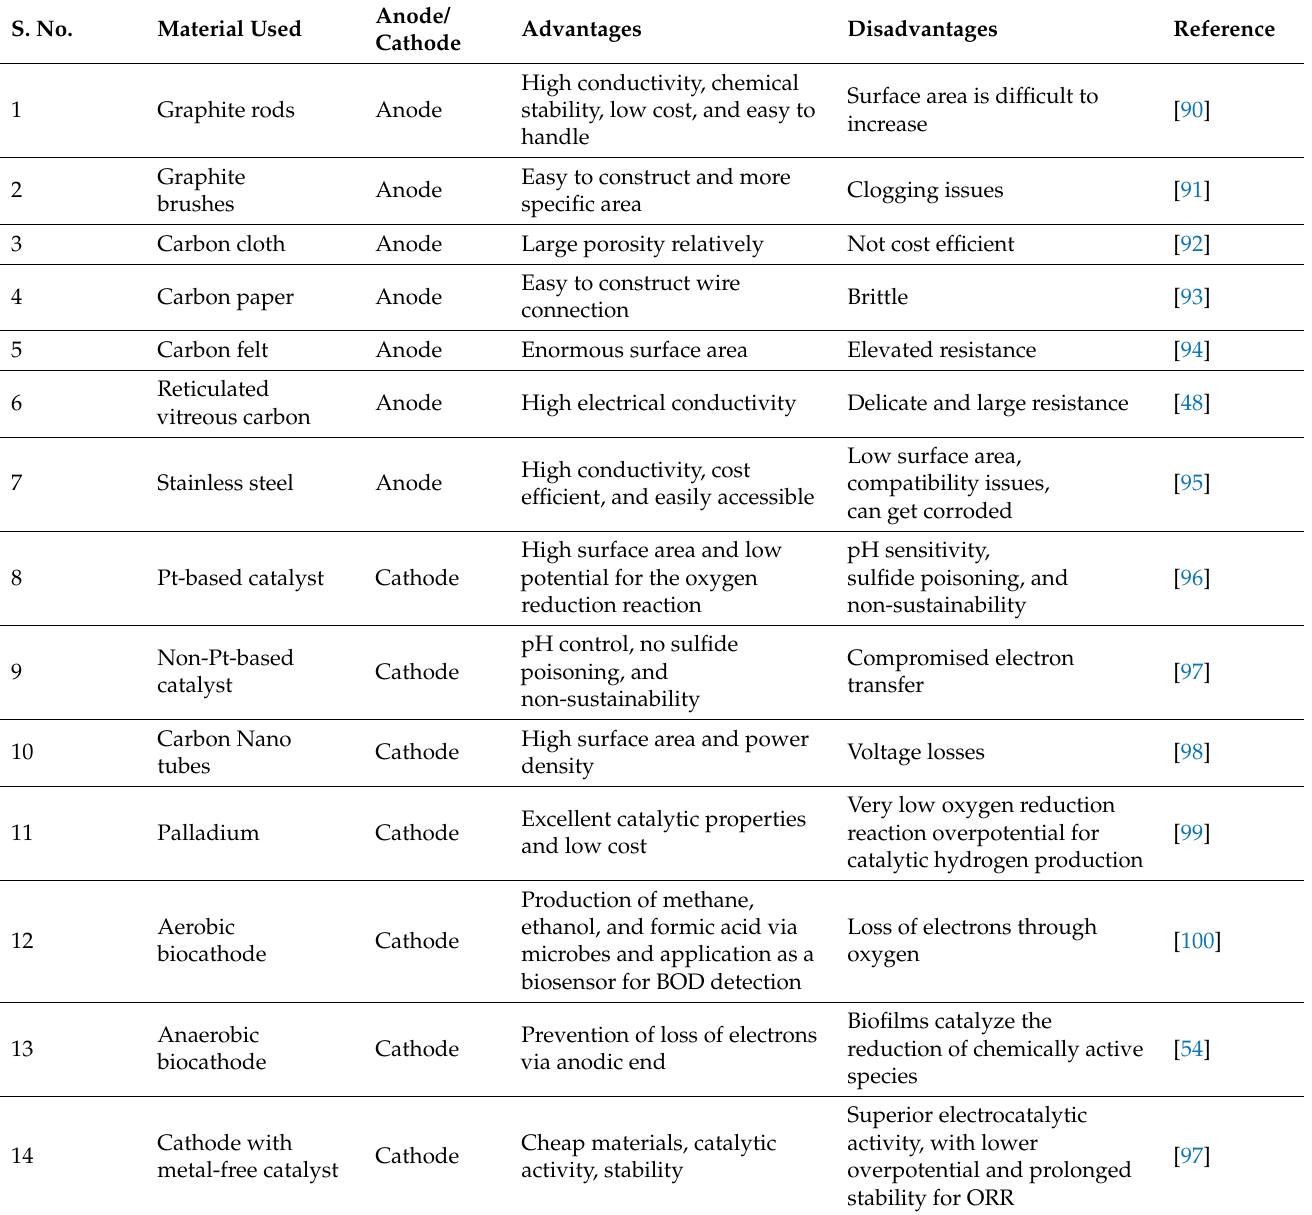
Table 2. Anode and cathode materials used in